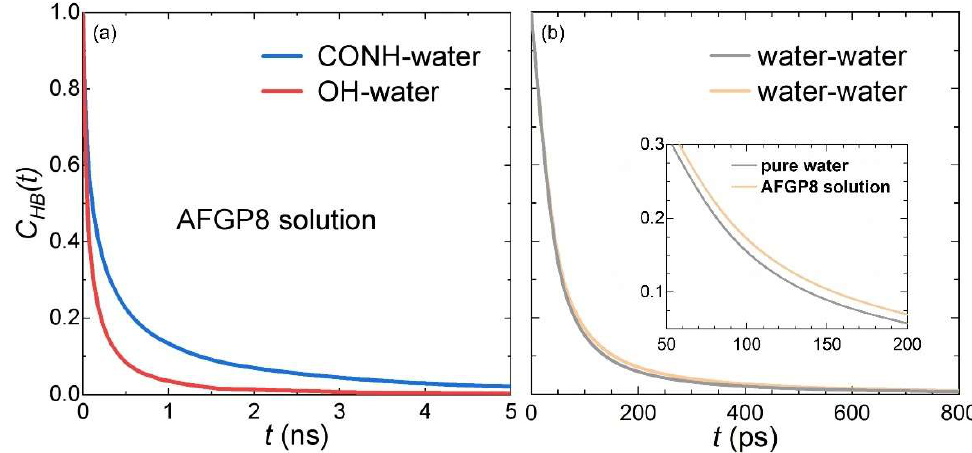
Figure 8. AFGP8 perturbs the hydrogen bond network of water. ( a ) The intermittent hydrogen bond autocorrelation functions of amide-water (blue line) and hydroxyl-water (red line) of AFGP8 in water at 268 K. ( b ) The water–water intermittent hydrogen bond autocorrelation functions in pure-water (black line) and AFGP8 solution (orange line) at 268 K.